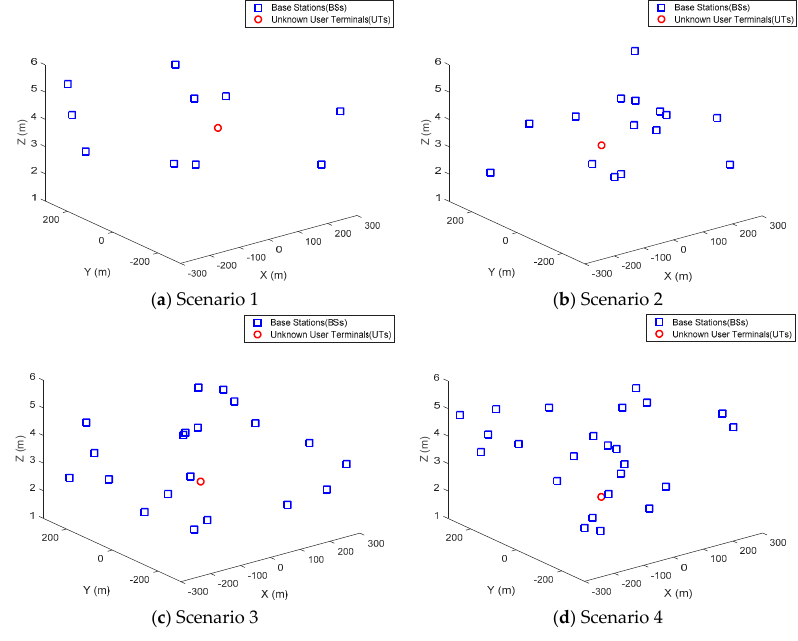
Figure 2. The 3 ‐ D positioning scenarios of the four experiments. Figure 2. The 3-D positioning scenarios of the four